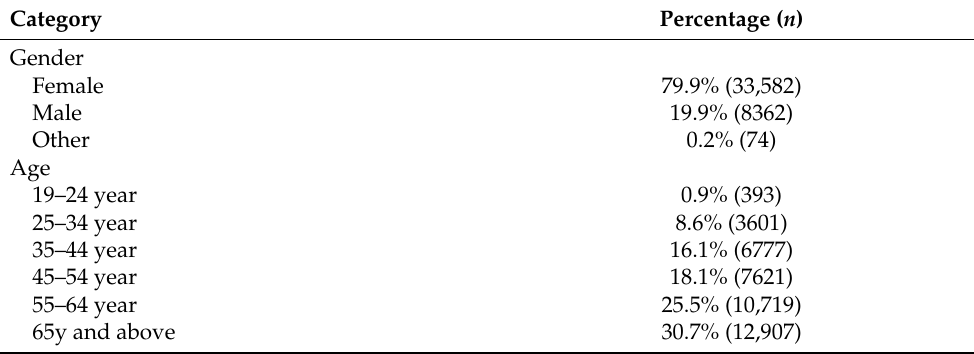
Table 1. Summary of the gender and age of participants in the IRi Survey ( n = 42,018).